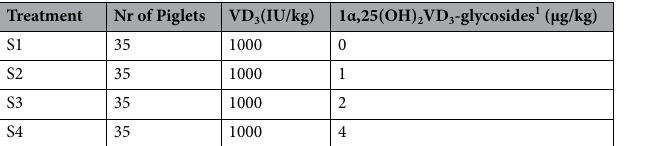
Table 2. Experimental treatments. 1 1α,25(OH) 2 VD 3 was provided as 1α,25(OH) 2 VD 3 -glycosides from plant origin.